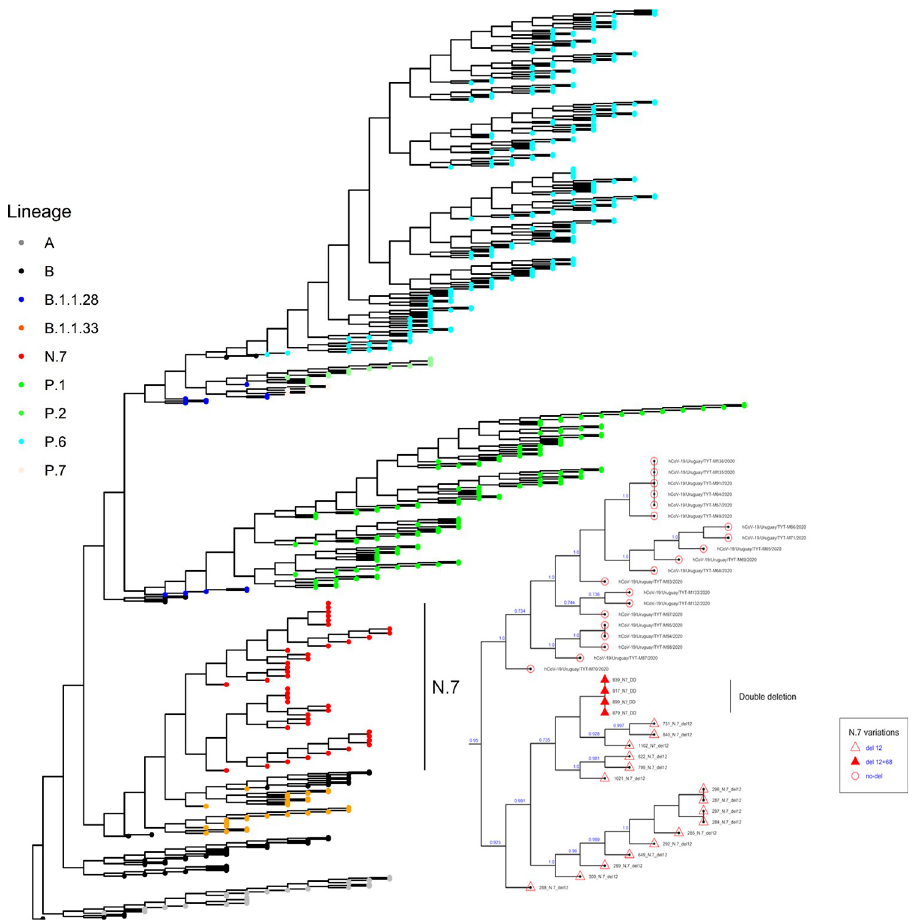
Fig 2. Maximum-likelihood tree based on 497 SARS-CoV-2 sequences. Details of the N.7 lineage composition are zoomed on the right.